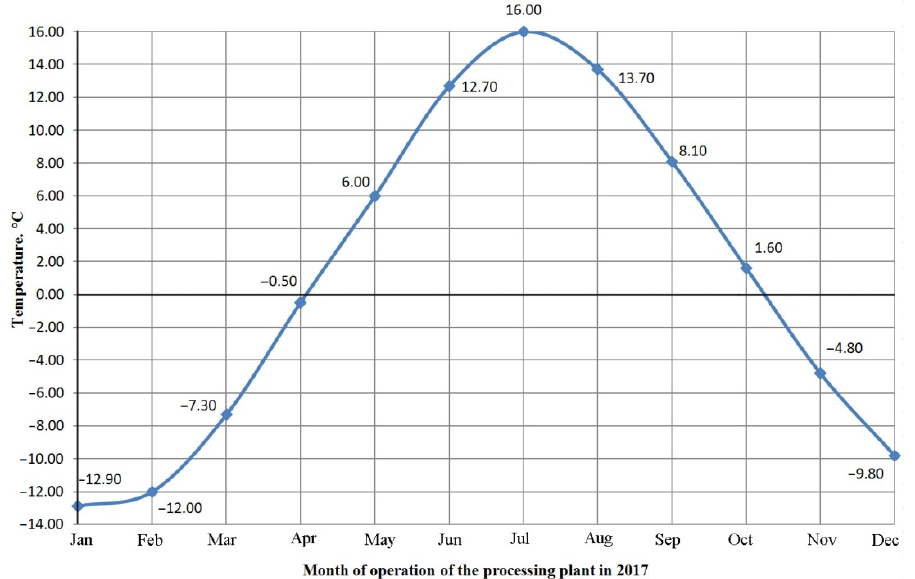
Figure 1. Influence of climatic parameters on the implementation of the technological process of the concentration plant [7,8].